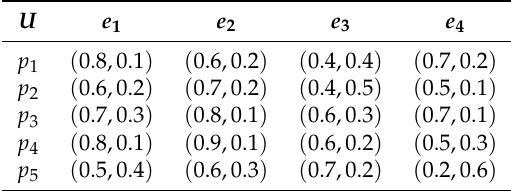
Table 1. Intuitionistic fuzzy soft set I = ( (cid:101) F , E )